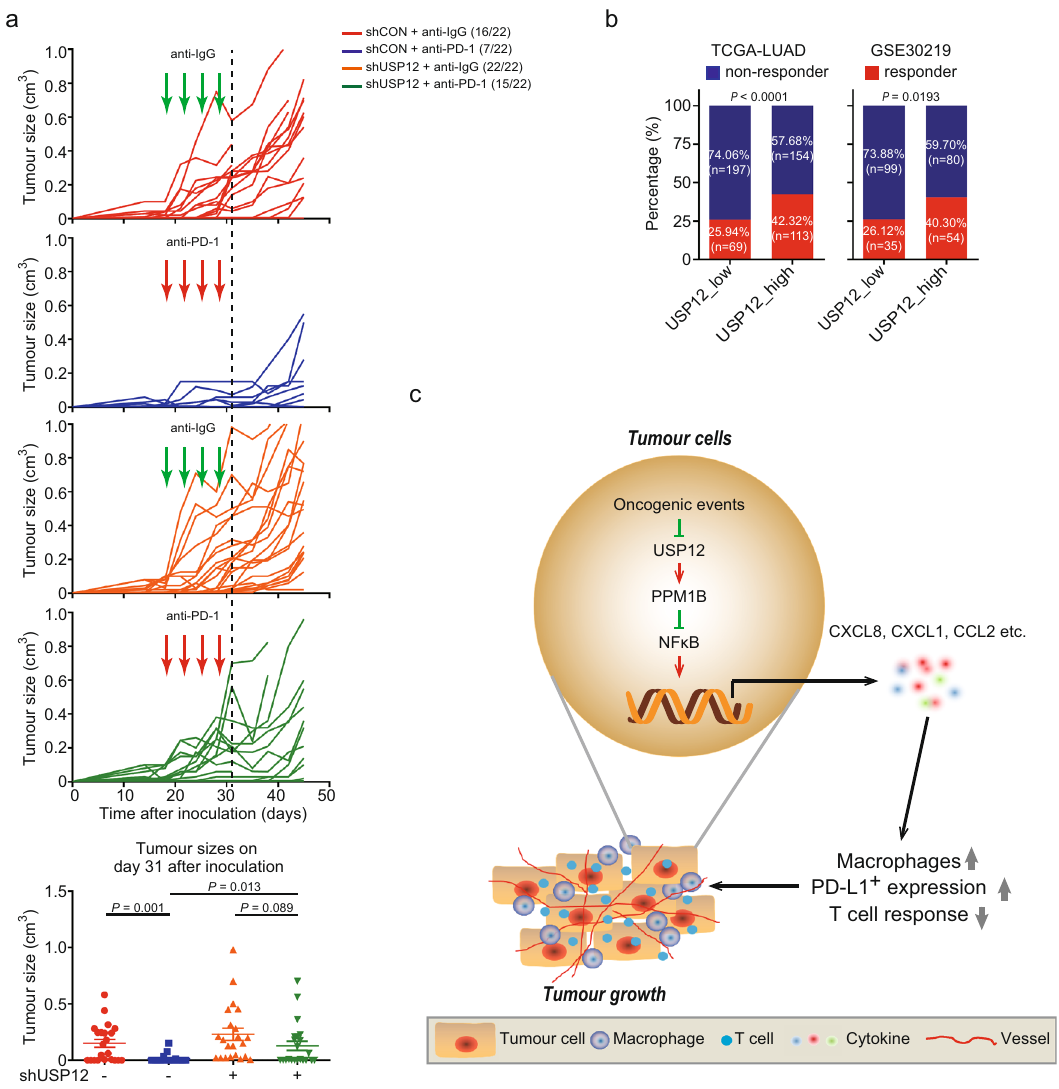
Fig. 6 USP12 inhibition renders lung cancer cells resistant to anti-PD-1 immunotherapy. a Top, growth kinetics in shCON- or shUSP12- 889-S1 tumours treated with anti-PD-1 or anti-IgG at days 18, 21, 24, and 28 ( n = 22 tumours from 11 mice). Bottom, tumour sizes of individual mice at day 31 (mean ± SEM, n = 22 per group). Kruskal-Wallis test. b Percentage of predicted responder and non-responder patients in the USP12_low and USP12_high groups from the TCGA-LUAD or GSE30219 databases. Fisher ’ s Exact Test. c Proposed model of the suppressive function of USP12 in the NSCLC development. USP12 downregulation by oncogenic events in NSCLC impairs PPM1B restriction of NF- κ B activation and thereby increases the expression of protumourigenic chemokine, leading to accelerated macrophage in fi ltration, angiogenesis, and T cell inactivation, and facilitating tumour growth and resistance to ICB